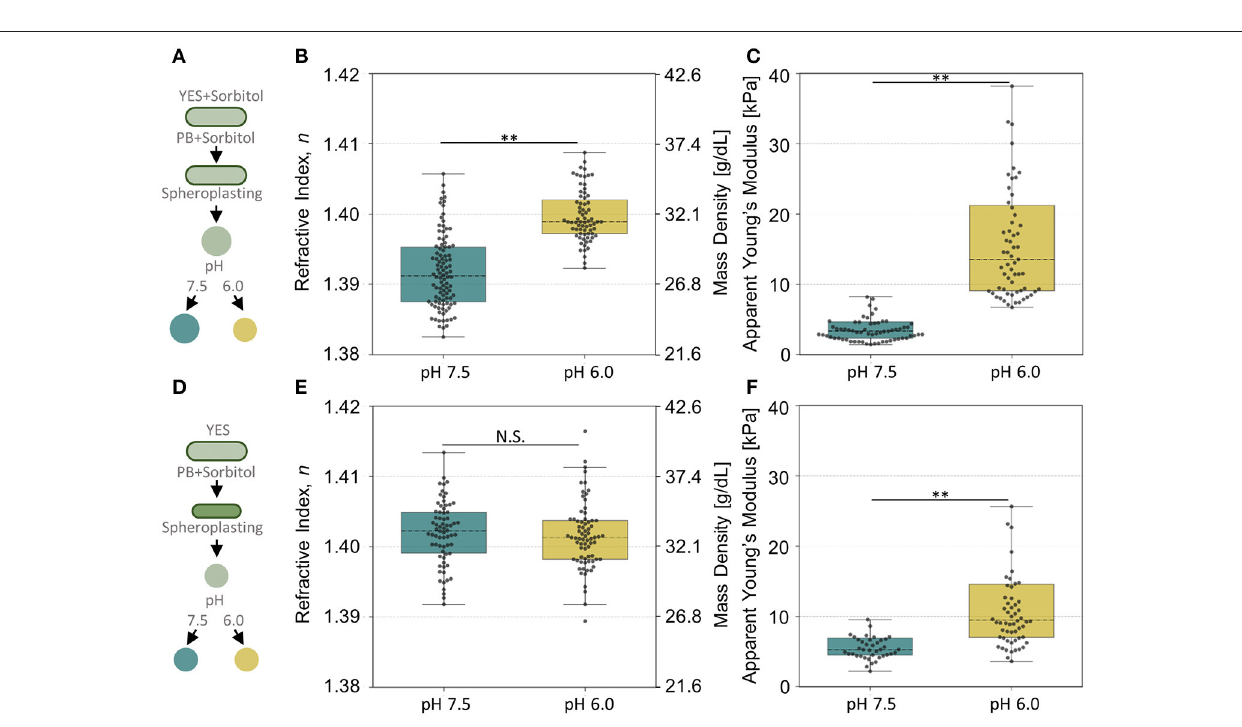
nature of these changes. Some suggested that the cytoplasm undergoes a glass transition due to increased mass density